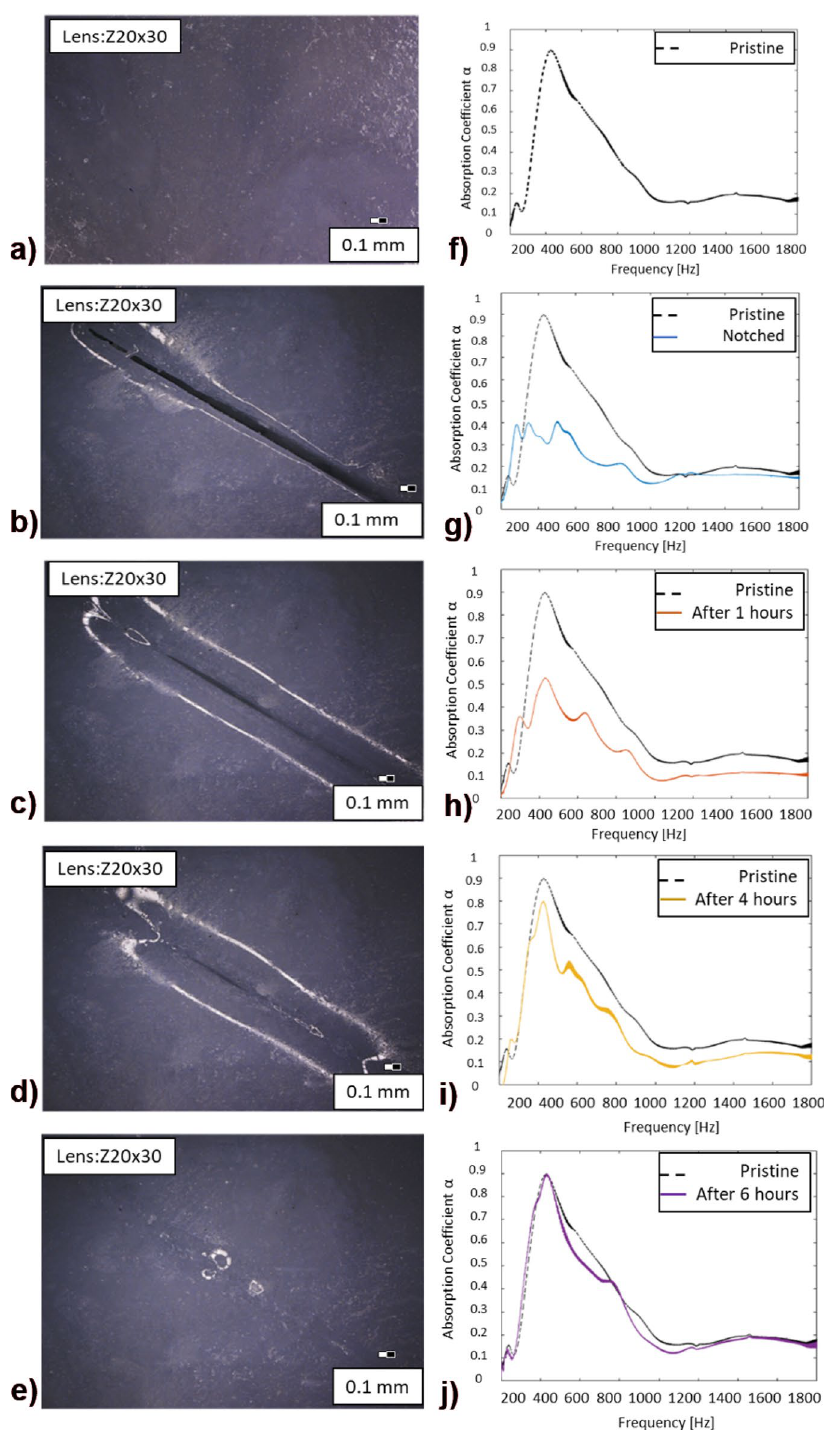
Figure 8. Time-lapse on the incised nNAMeG; ( a–e ) Optical light microscope imaging; ( f–i ) absorption coefficient measurements on the engraved nNAMeG in comparison to pristine sample; ( a,f ) before incision; ( b,g ) after initial incision; ( c,h ) after 1 h; ( d,i ) after 4 h; ( e,j ) after 6